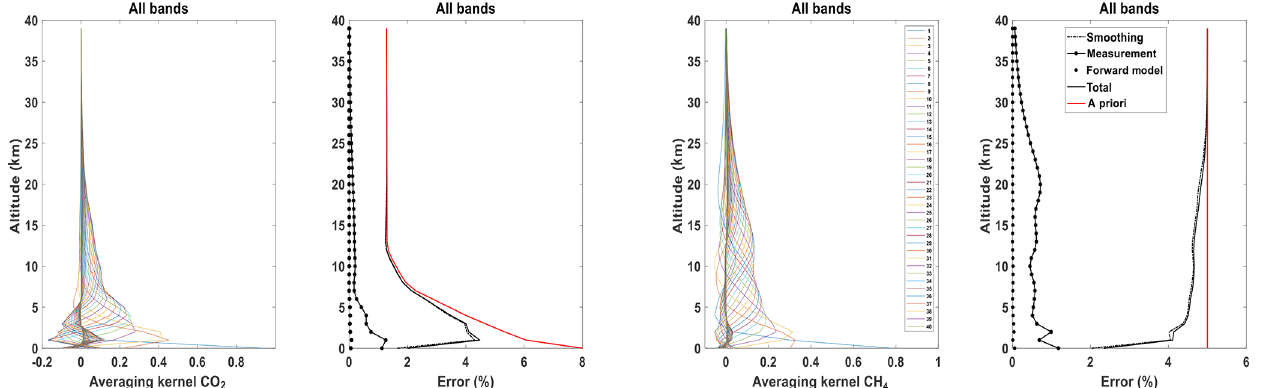
Figure 10. Averaging kernels and error budgets of vertical CO 2 and CH 4 profiles for all the bands together for the EM27/SUN and CHRIS combined for an angle of 10 ◦ . The red and black lines stand for the prior ( S a ) and posterior ( S x ) errors, respectively; the smoothing ( S smoothing ), measurement ( S meas. ) and forward model parameter ( S fwd.mod. ) errors are dash-dotted, dash-starred and dotted, respectively. Table 4. The DOFSs and column errors (%) of CO 2 for each band and for each instrument. TB B1 B3 B4 All bands DOFSs DOFSs Error CHRIS Angle 10 2.01